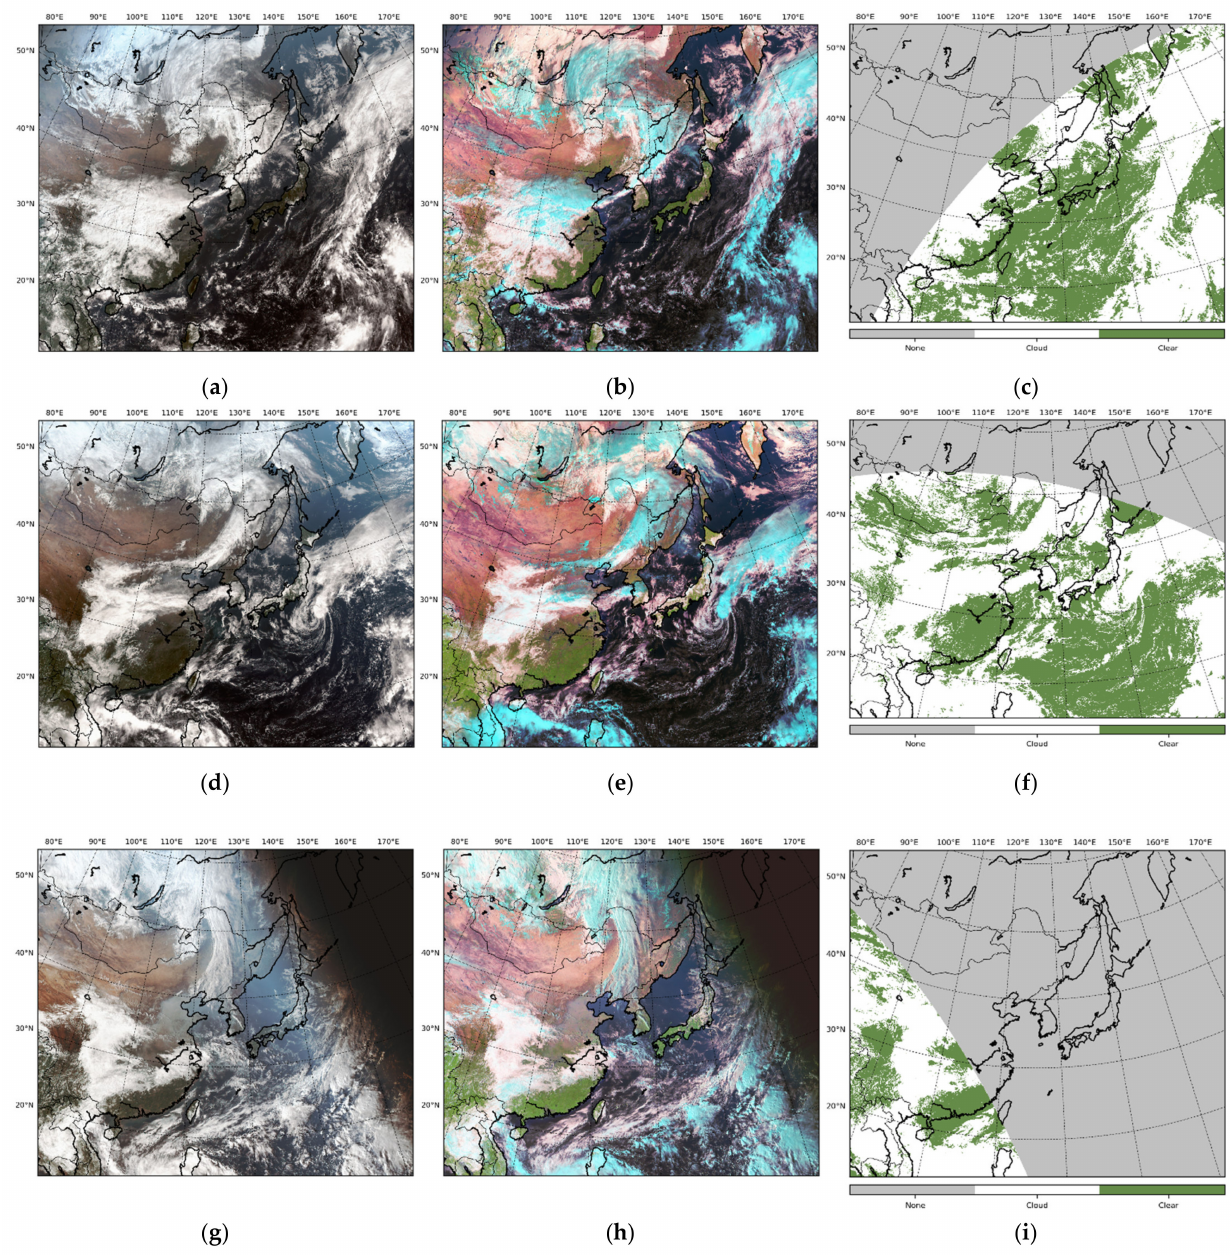
Figure 10. Qualitative comparison with GK-2A-based true color and natural color RGB in October 2020. Images are listed in the order of the true color, natural color, and proposed cloud mask, and each row is separated by date: ( a – c ) are examples at 01 UTC on 2 October 2020; ( d – f ) are at 04 UTC on 11 October 2020; and ( g – i ) are at 07 UTC on 26 October